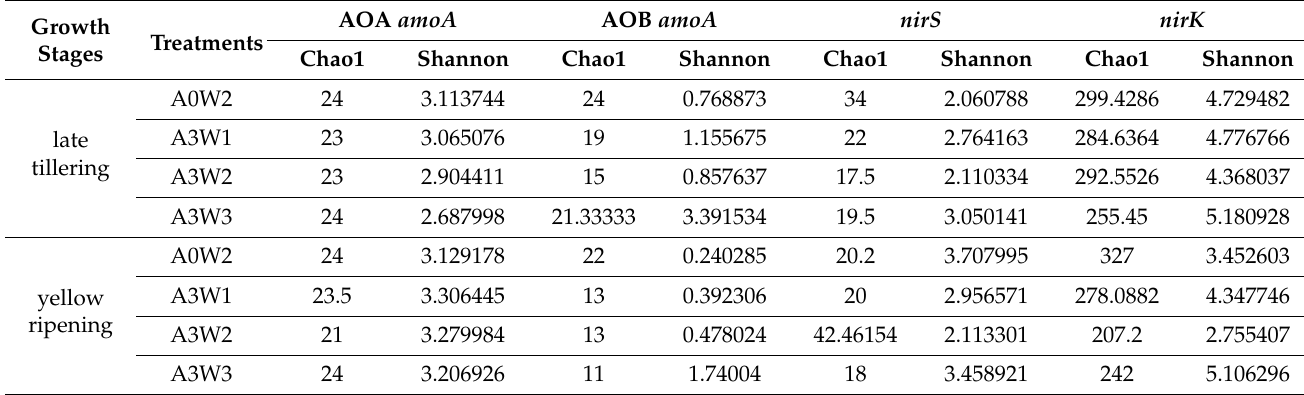
Table 3. Nitrogen conversion gene’s observed Chao1 and Shannon